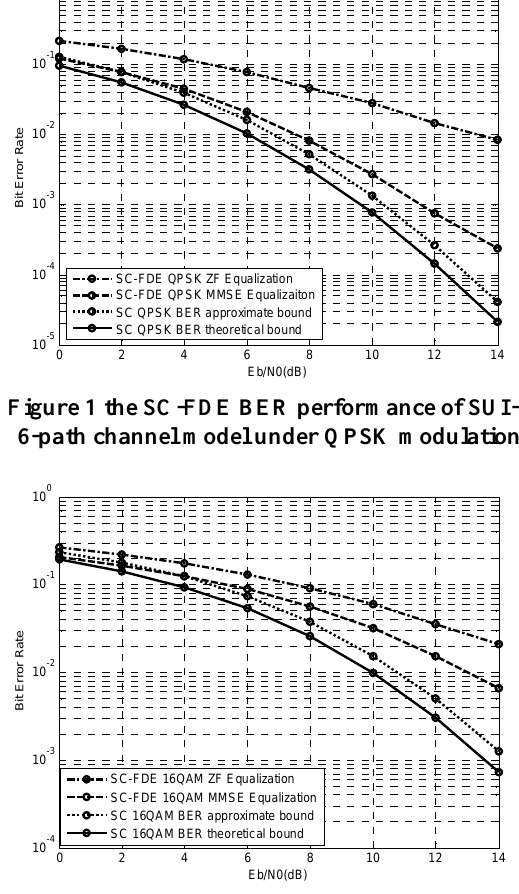
Figure 2 the SC-FDE BER performance of SUI-3 6-path channel model under 16QAM